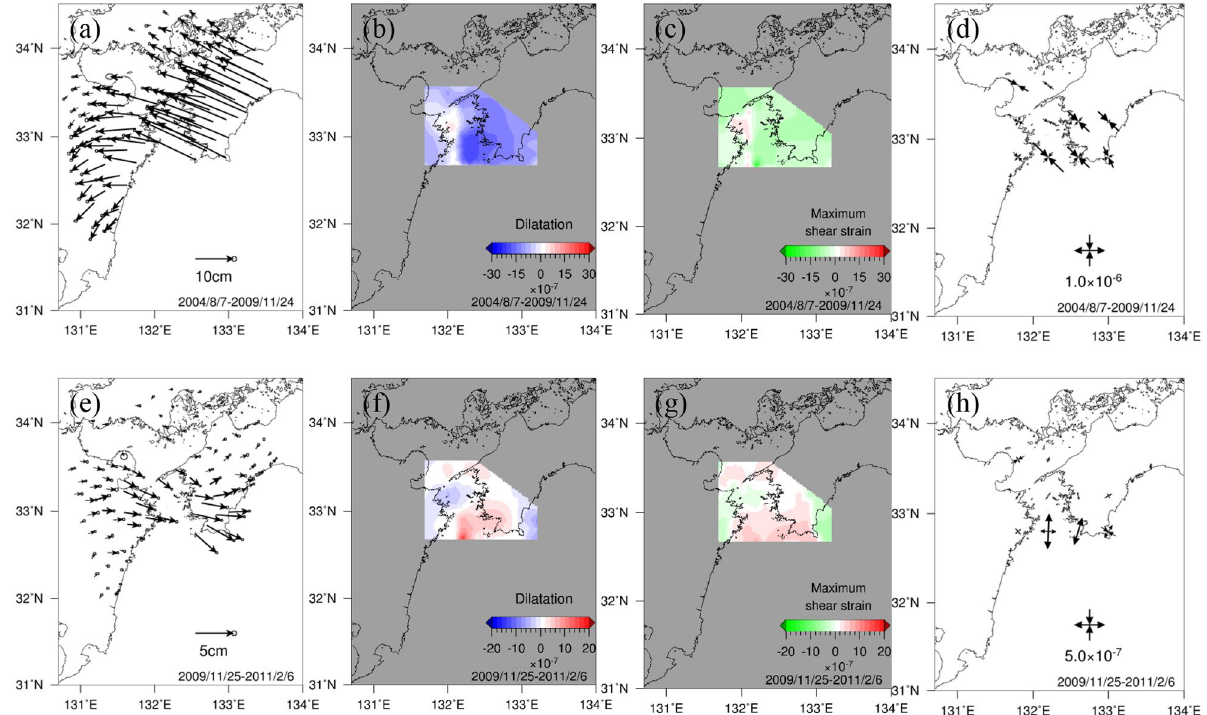
Figure 2. Spatial distributions of displacement, dilatation, maximum shear strain, and principal strain before (7 August 2004–24 November 2009) and during (25 November 2009–6 February 2011) the Bungo Channel L-SSE (1). ( a )–( d ) represent before the L-SSE, and ( e )–( h ) denote during the L-SSE. ( a ), ( e ) Spatial distribution of displacement. Black arrows show horizontal displacements during the analysis period. The ellipse at the tip of the black arrow represents the 1σ error ellipse. ( b ), ( f ) Spatial distribution of dilatation. The blue and red areas represent contraction and expansion, respectively. ( c ), ( g ) Spatial distribution of maximum shear strain. The green and red areas show compressive and tensile fields, respectively. ( d ), ( h ) Spatial distribution of principal strain. The black outwards and inwards arrows show tension and compression, respectively. The map was created by using the Generic Mapping Tools (GMT) 27 (version: GMT3.4.6, URL link: https:// www. gener ic- mappi ng- tools. org/ downl